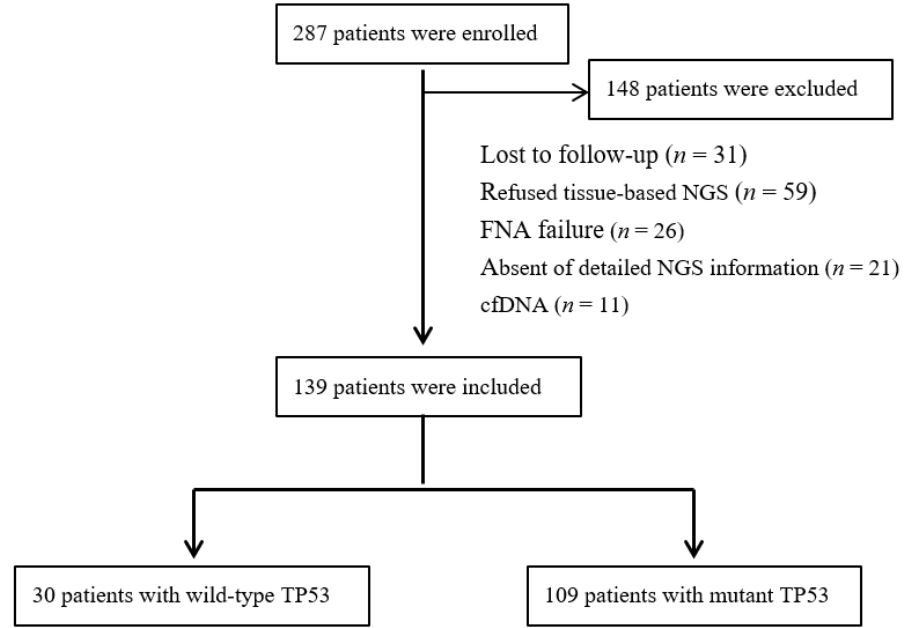
Figure 1. Flowchart of patient selection.